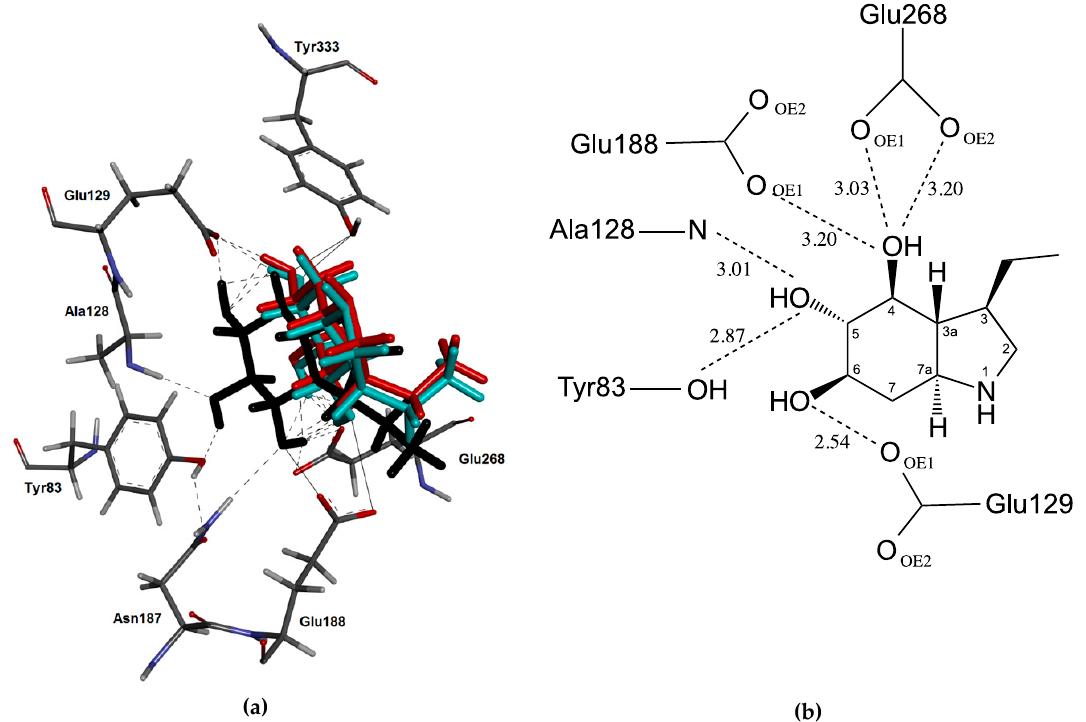
Figure 5. ( a ) Top poses obtained for compound 13 in early termination runs with the various scoring functions used. The ChemScore structure is drawn in red, while the GoldScore and ChemPLP are drawn in black and cyan, respectively. ( b ) Hydrogen bond interactions between the ligand and the protein residues, resulting from the GoldScore scoring protocol run.